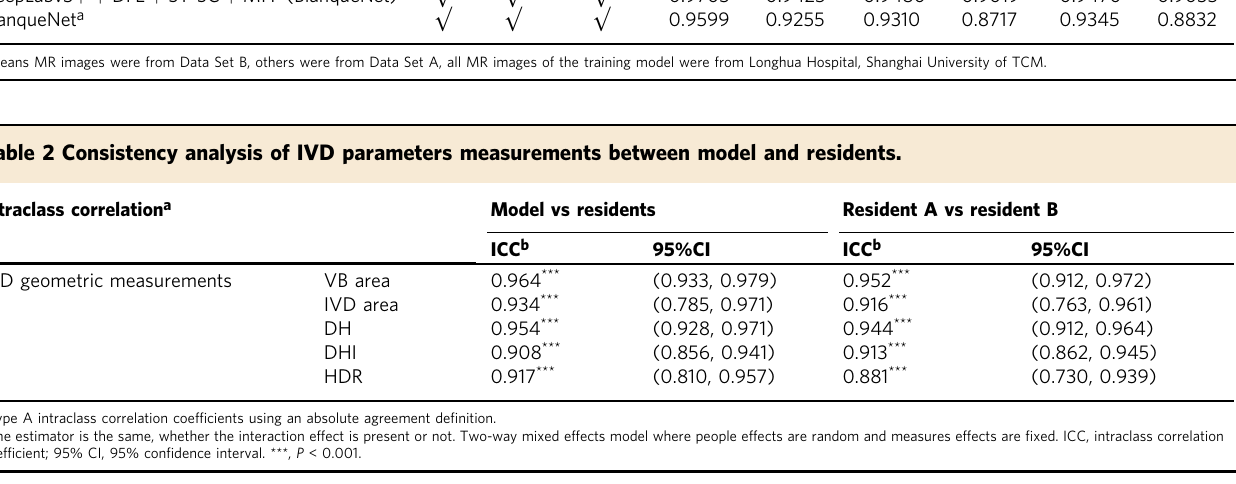
Table 3 The results of multiple regression analysis of 4 SI, DH, DHI, HDR and gender, different ages, and different segments. measure-ment Δ SI female